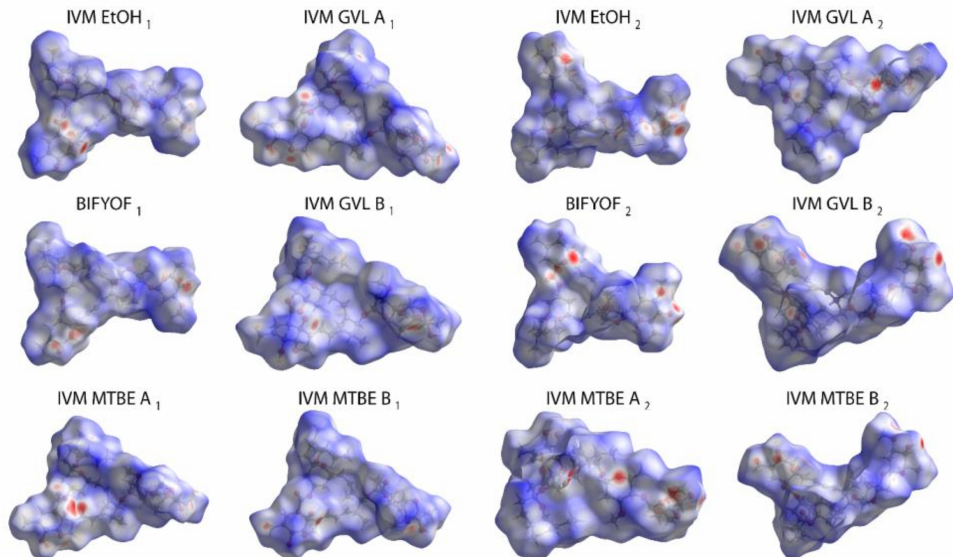
Figure 8. Hirshfeld surfaces of IVM in the analyzed structures. All surfaces designated by 1 (on the left) correspond to front view, whereas surfaces designated by 2 (on the right) correspond to the back view. A and B designates each of symmetrically independent